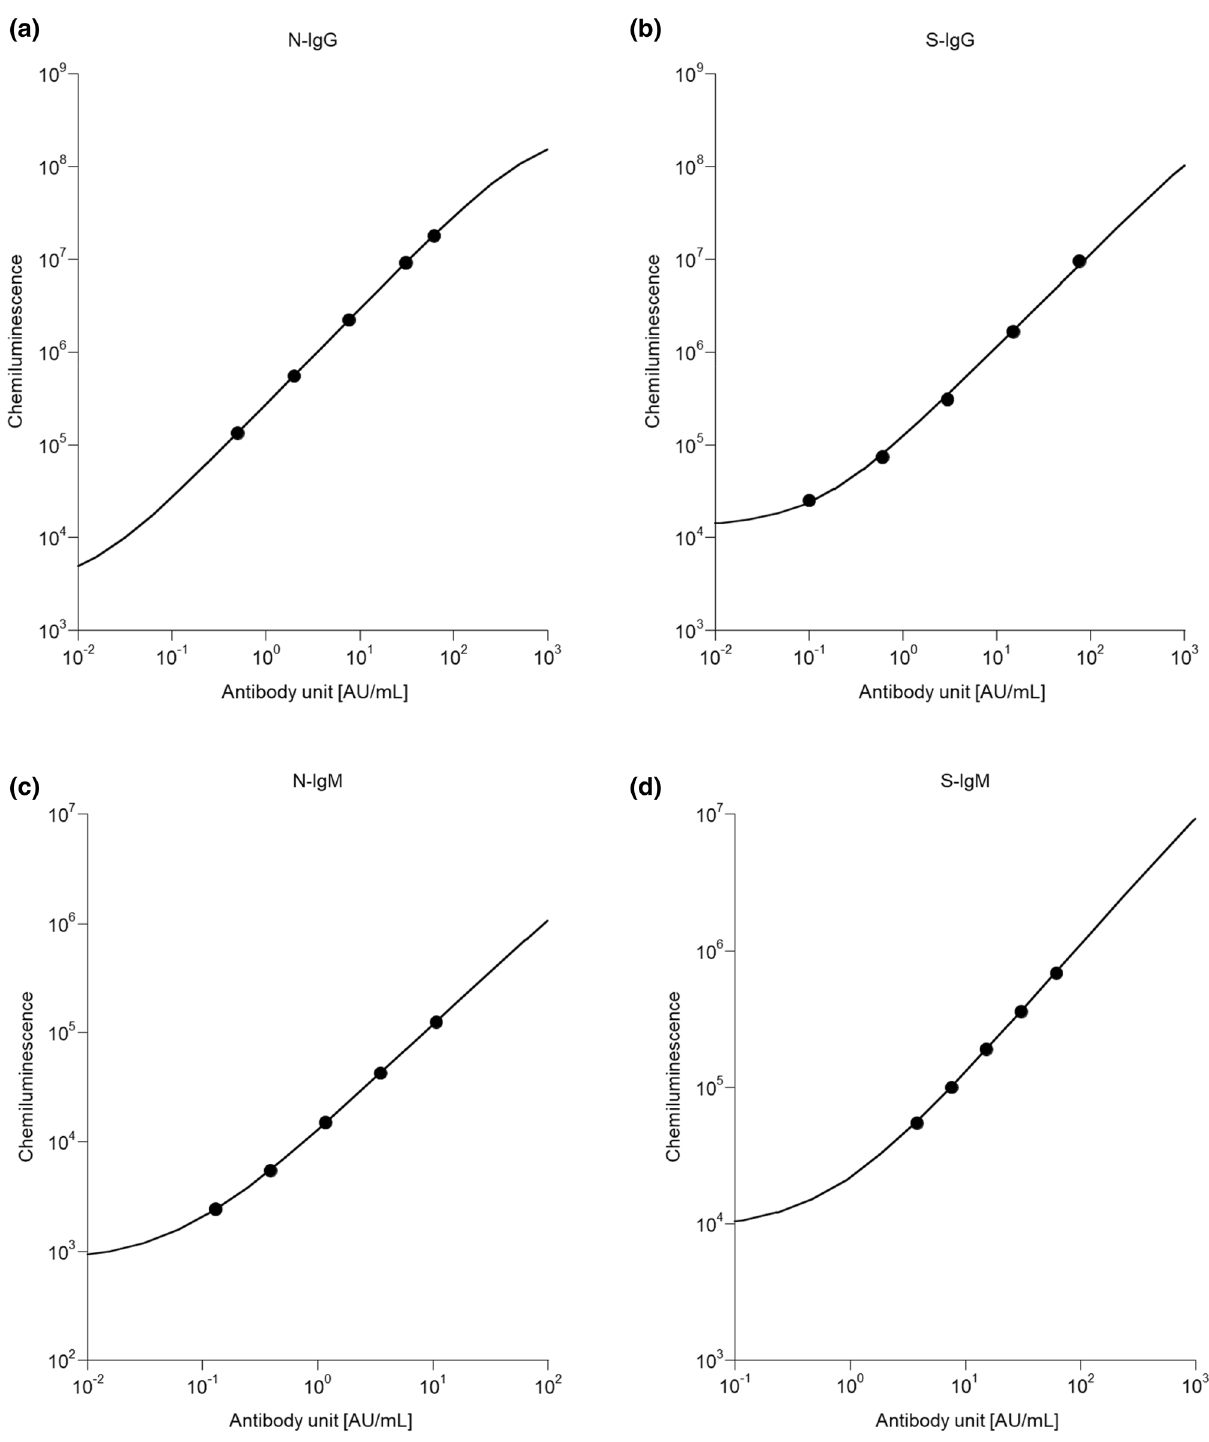
Figure 1. Relationship between chemiluminescence and the levels of each antibody. Working curve of N-IgG ( a ), S-IgG ( b ), N-IgM ( c ), and S-IgM ( d